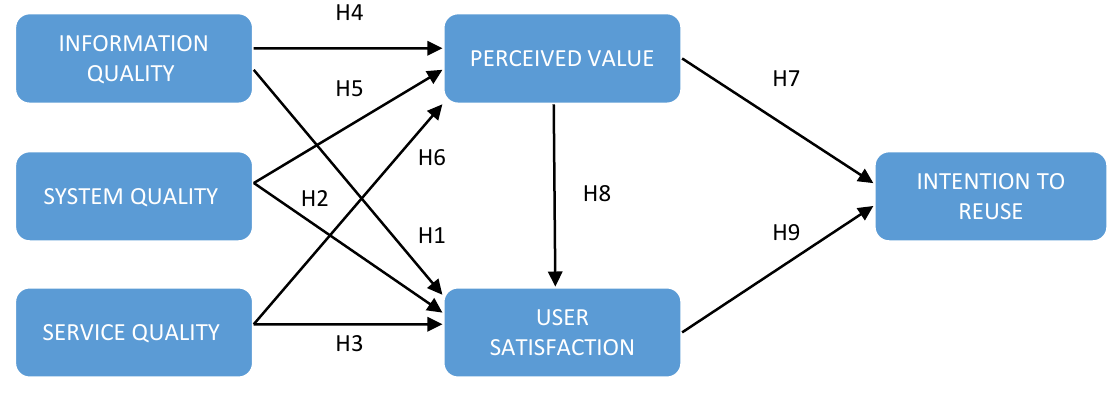
Figure 2. The research model of e-commerce systems